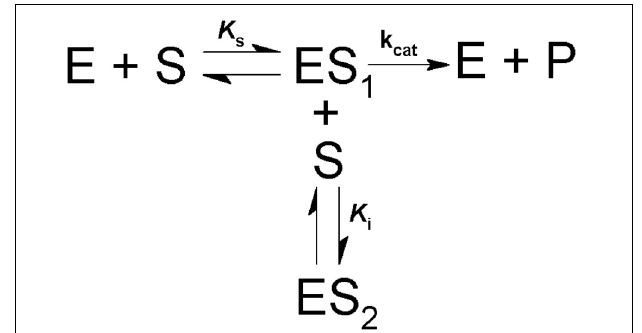
FIGURE 1 | Comparison of α -glucosidase activity using as substrate MU α Glu (black bars) or sucrose (gray bars) in different tissues of recently emerged (0–3 h) L. longipalpis females. The results are the mean ± SEM of three biological replicates each with n = 12.